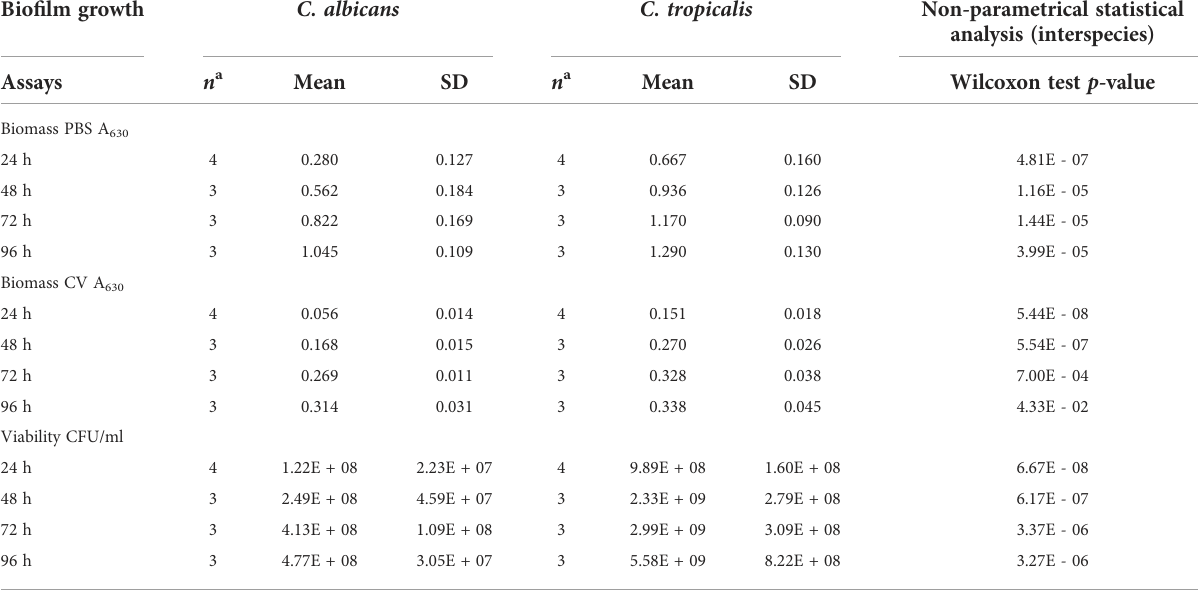
TABLE 2 Evaluation of the statistical differences in bio fi lm growth between Candida albicans and Candida tropicalis through biomass and viability assays. Bio fi lm